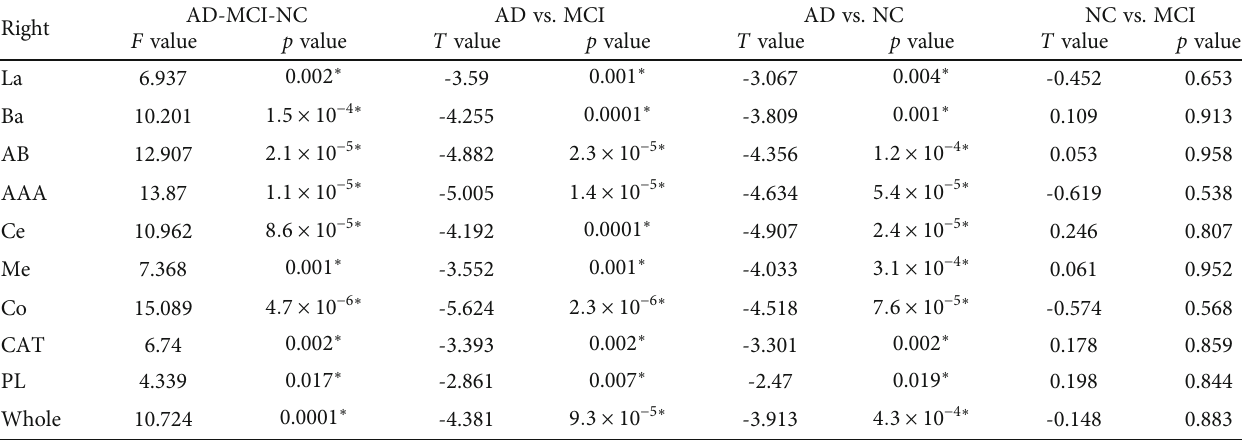
Table 7: ANOVA test and multicomparison results of the subregion volumes of the right amygdala between the three groups. Right